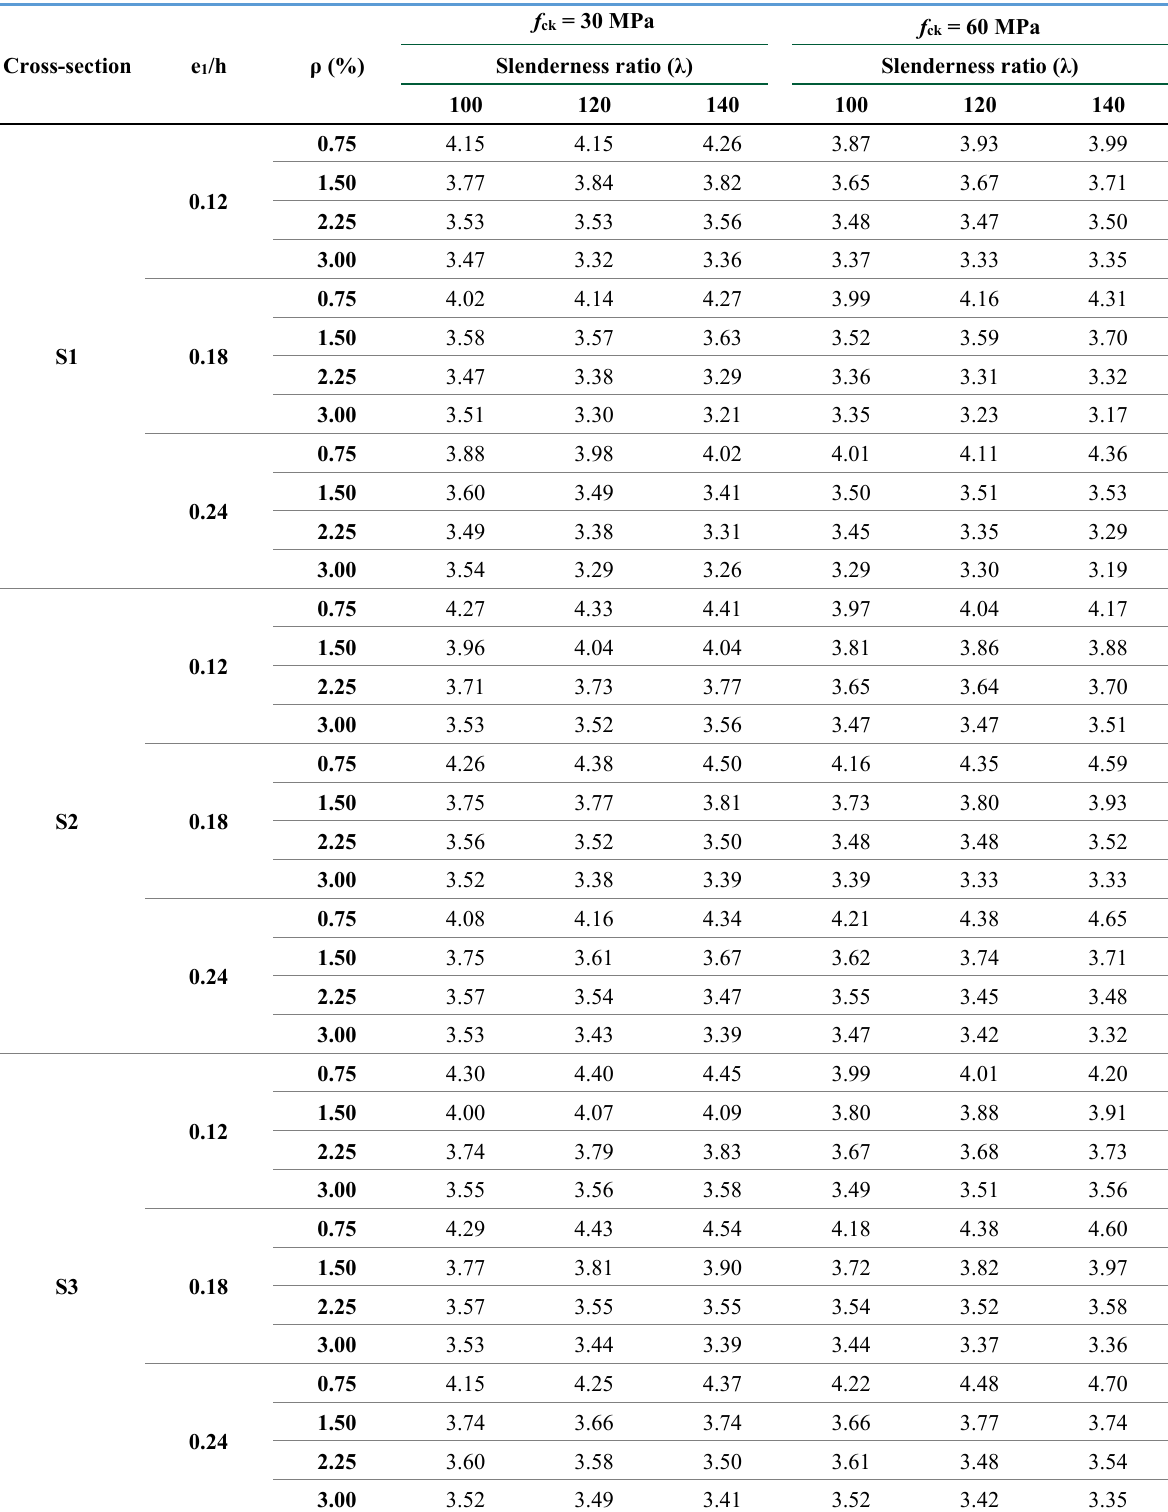
Table 4. Reliability index of the tested columns.